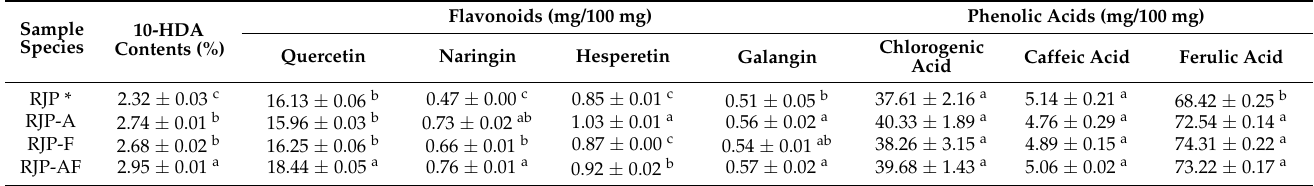
Table 1. Contents of 10-HDA and various flavonoids and phenolic acids in royal jelly protein (RJP) and their hydrolysates. Sample